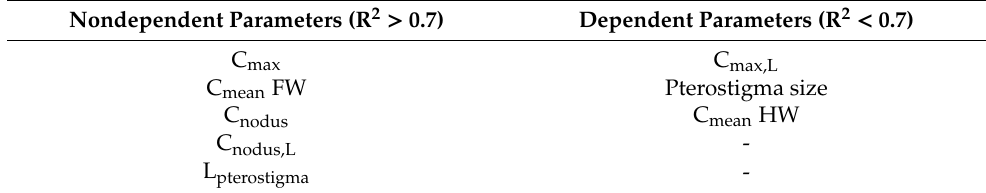
Table 2. List of family-dependent and nondependent geometric parameters of the dragonfly wing.